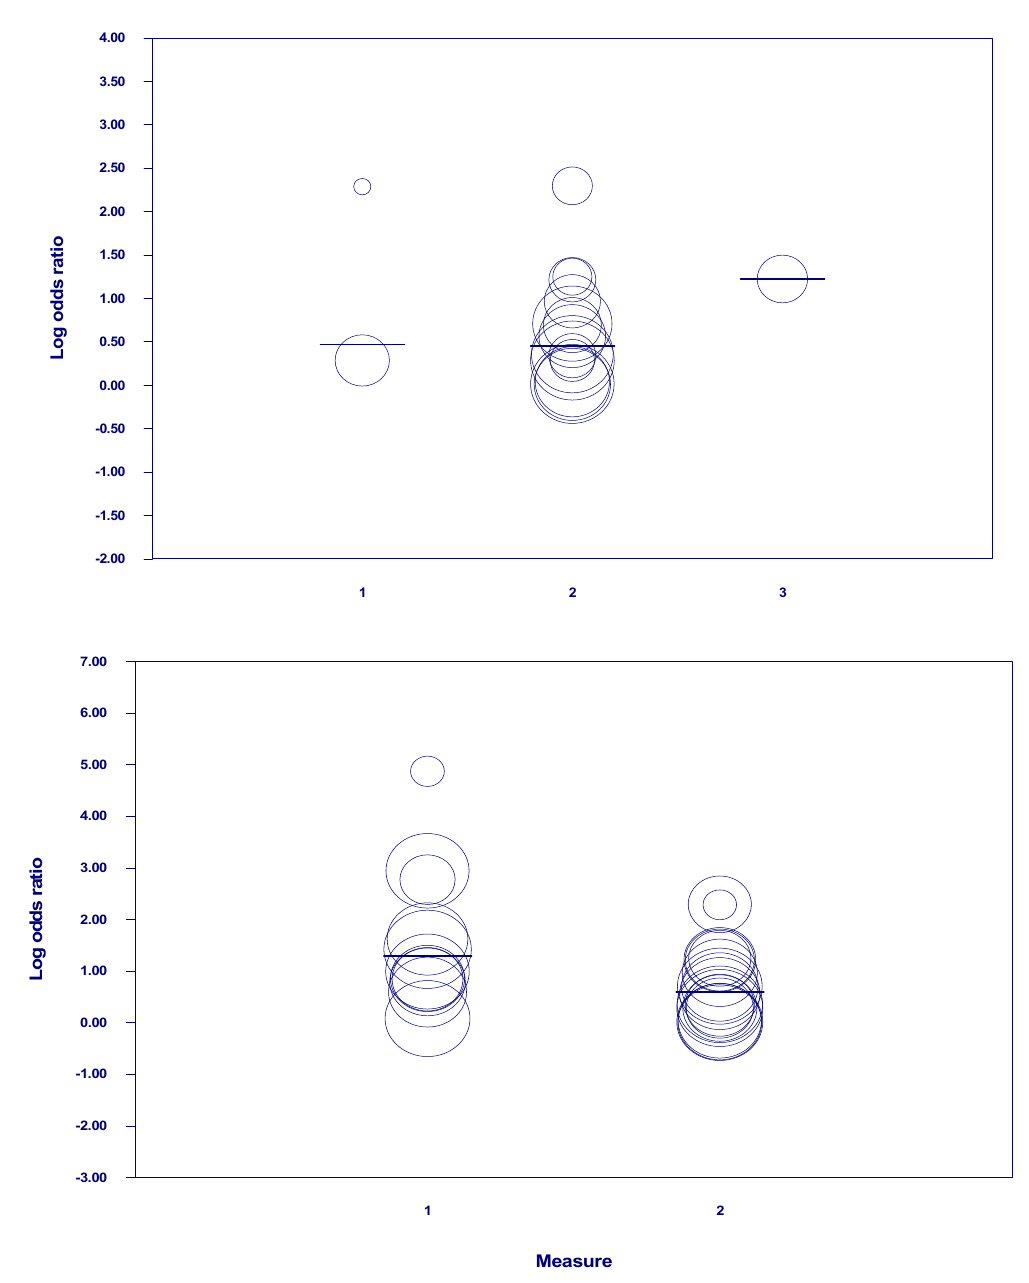
Figure 3. Meta-regression of log odds ratio on type of measure, symptomatic tool, and CES-D cut-offs (95% intervals are simultaneous and based on Z distribution). Scatterplots show the relationship between each covariate and AD.